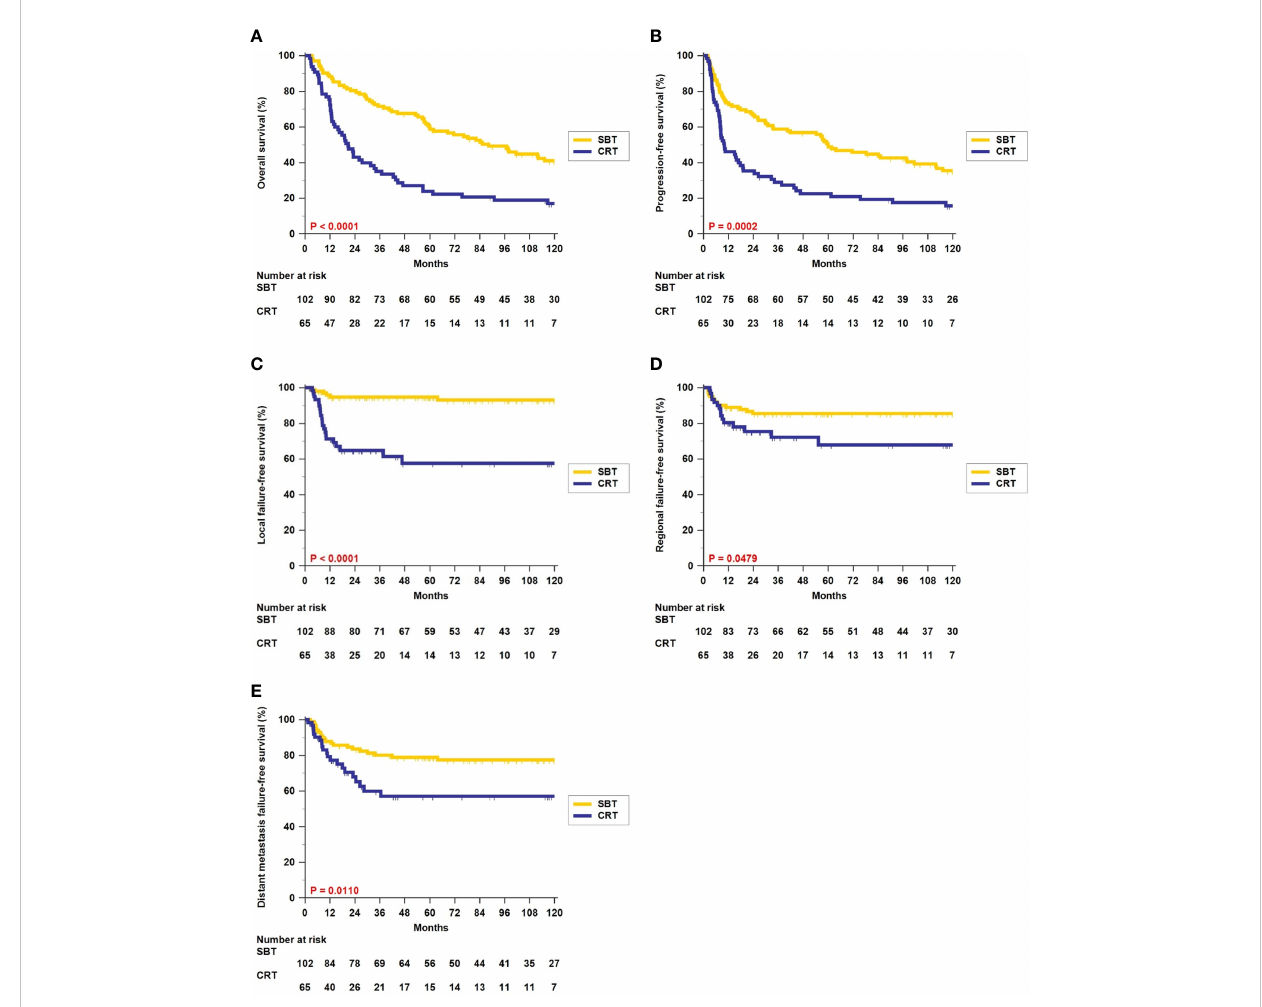
FIGURE 1 Kaplan – Meier estimates of overall survival (A) , progression-free survival (B) , local failure-free survival (C) , regional failure-free survival (D) , and distant metastasis failure-free survival (E) between surgery-based therapy (SBT) and de fi nitive chemoradiotherapy (CRT) for all 167 hypopharyngeal carcinoma (HPC)